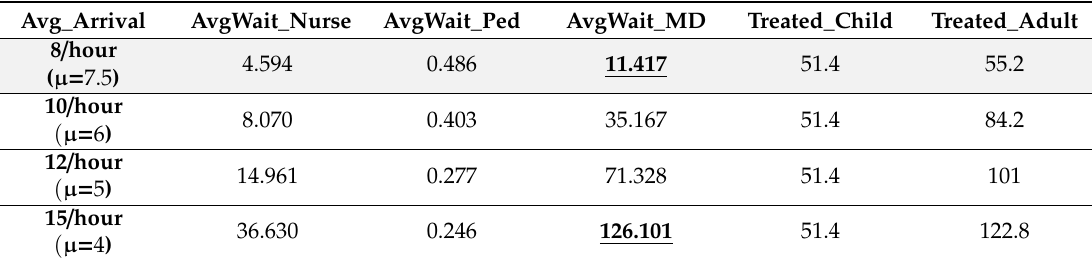
Table 2. Average waiting time for an adult patient without any increase in sta ffi ng in minutes.